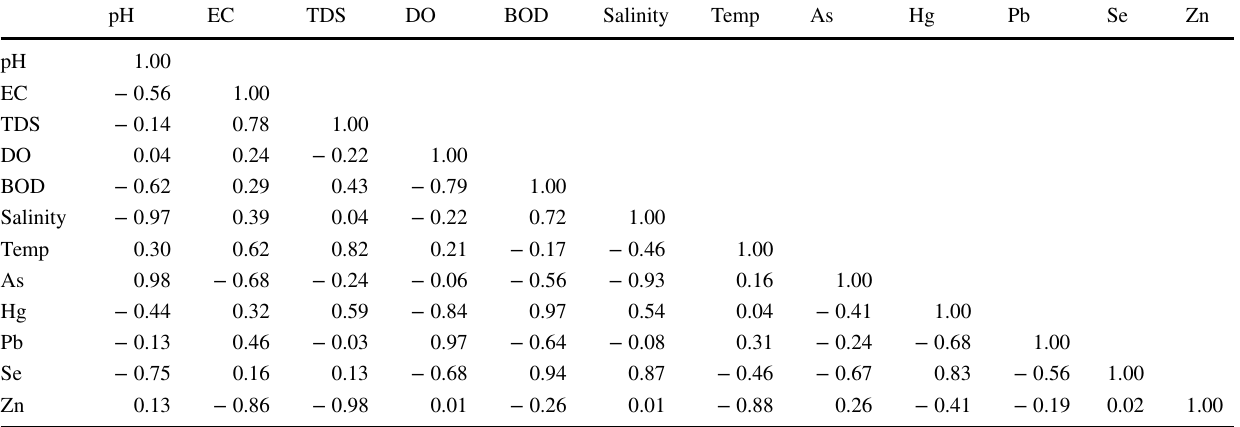
Table 5 Pearson’s correlation coefficient between physicochemical parameters and heavy metal concentration in water samples analyzed in